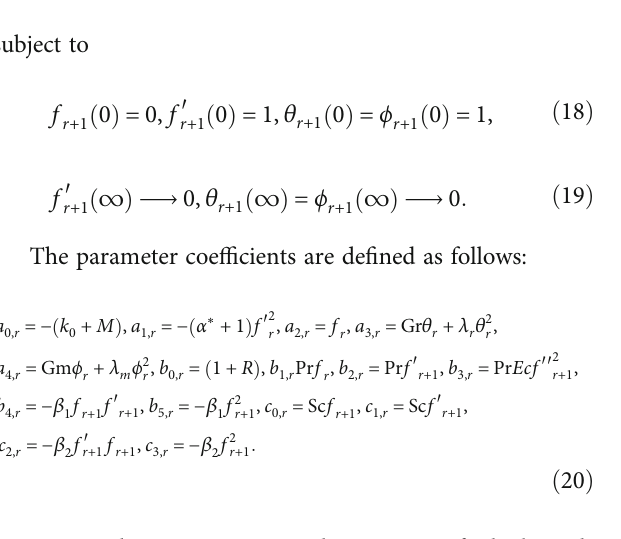
Figure 9: Signi fi cance of the magnetic parameter on velocity pro fi